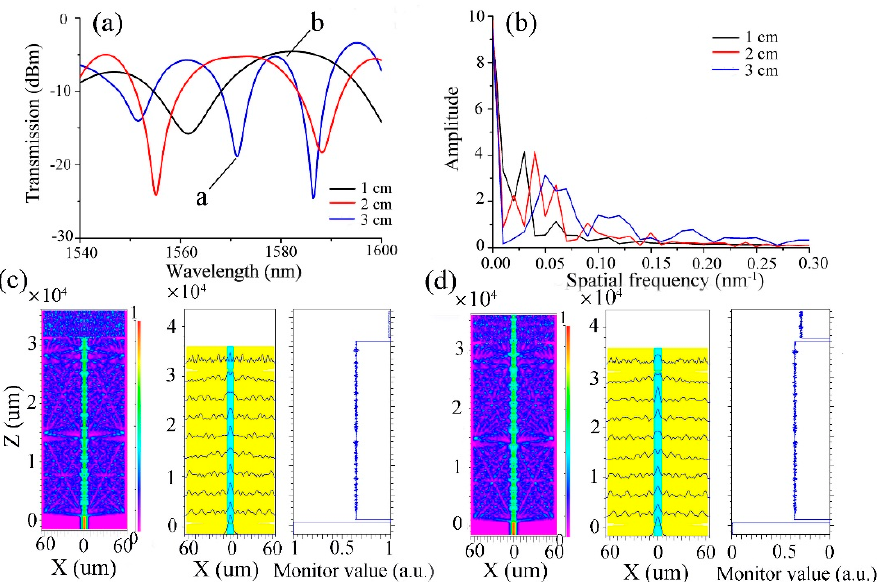
Figure 2. ( a ) The simulated spectral response of the fiber MZI with arm lengths L of 1, 2, and 3 cm, respectively; ( b ) the corresponding spatial frequency; ( c , d ) the distributions of the optical field and the normalized optical intensity propagating along the MZI with an arm length of 3 cm at dip a 1571.2 nm and peak b 1578.8 nm.